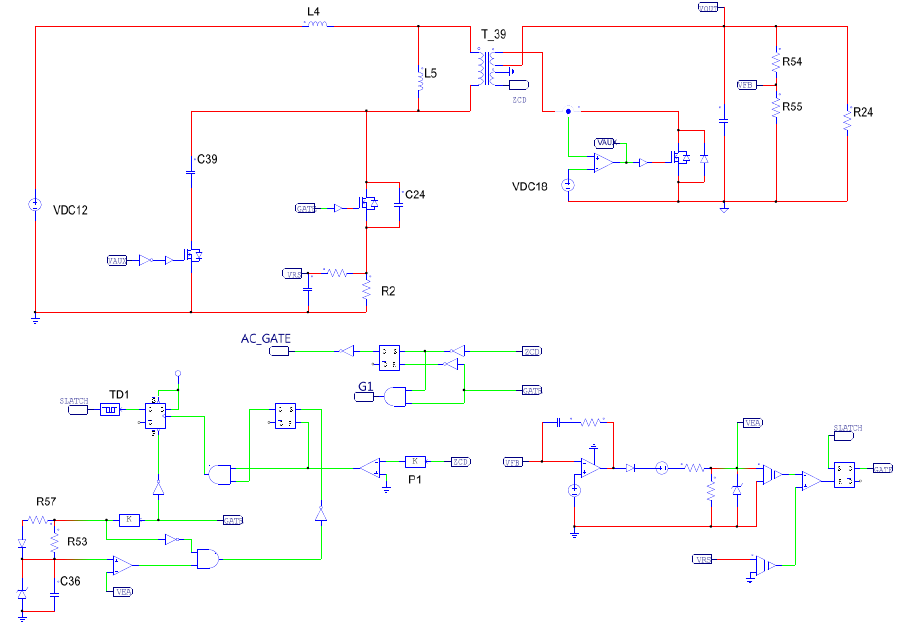
Figure 13. PSIM simulation schematic of QR flyback converter with SDAS.